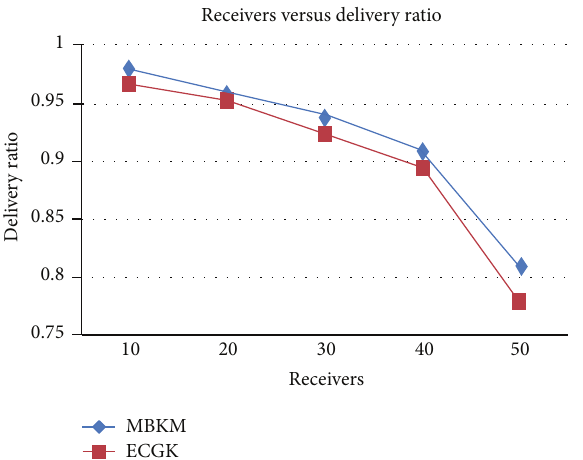
Figure 10: Comparison of delivery ratio with ECGK for varying receivers.